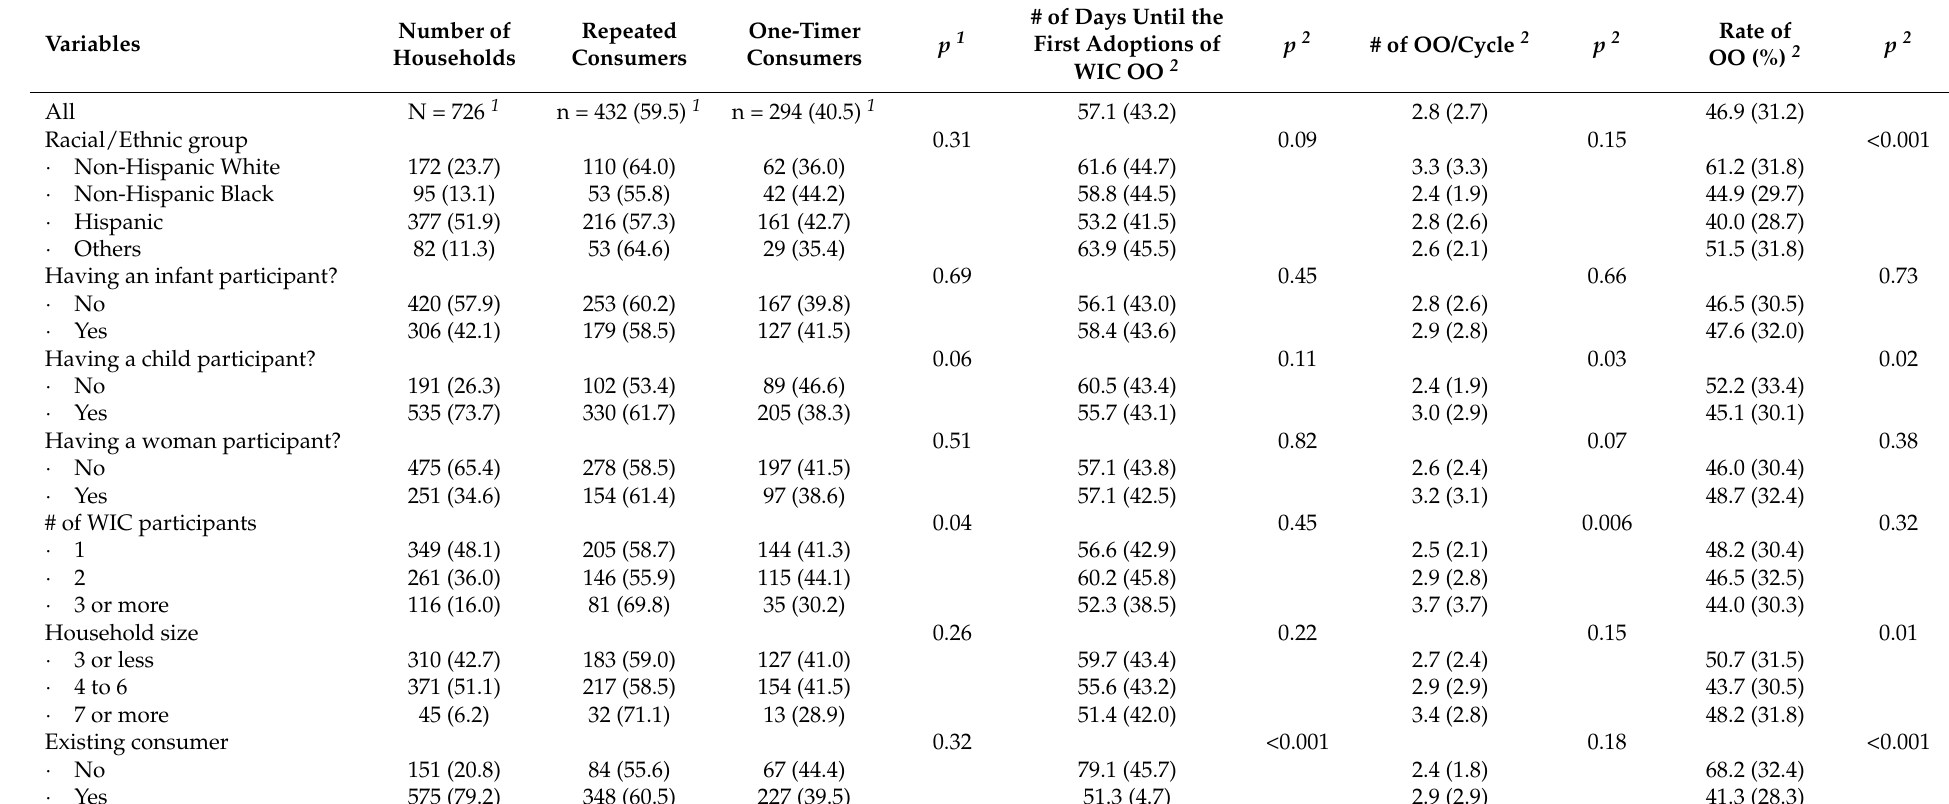
Table 1. Descriptive statistics of online ordering (OO) shoppers (OK-WIC-XYZ) (# of households =